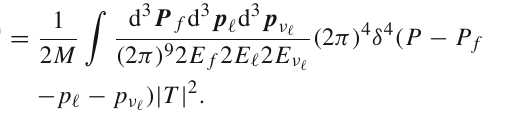
Table 4 The results of semi-leptonic production of 3 P state D ∗